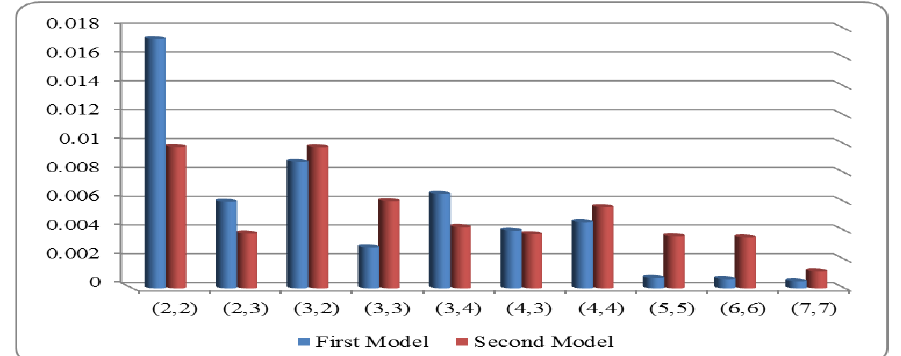
Figure 1. MSEs of 1 ˆ R and 2 ˆ R for both models at R = 0.525. Figure 1. MSEs of ˆ R 1 and ˆ R 2 for both models at R = 0.525.